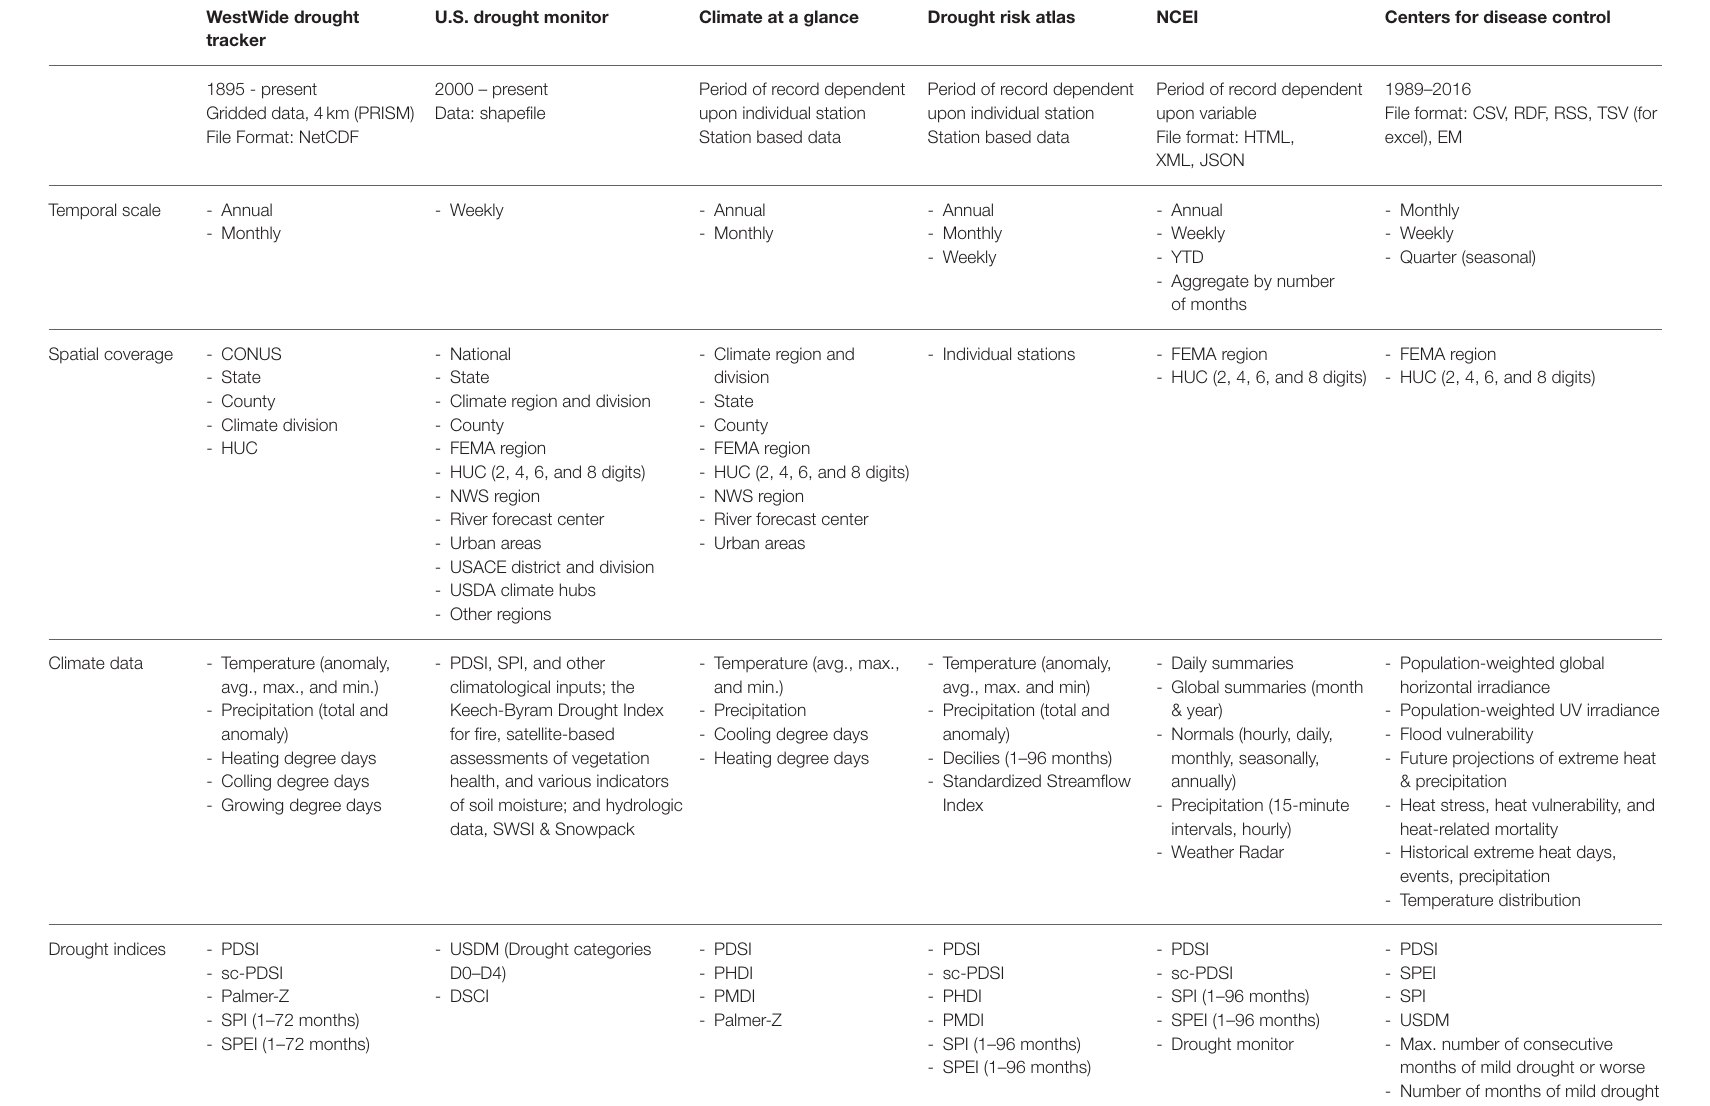
TABLE 1 | Climate and drought data